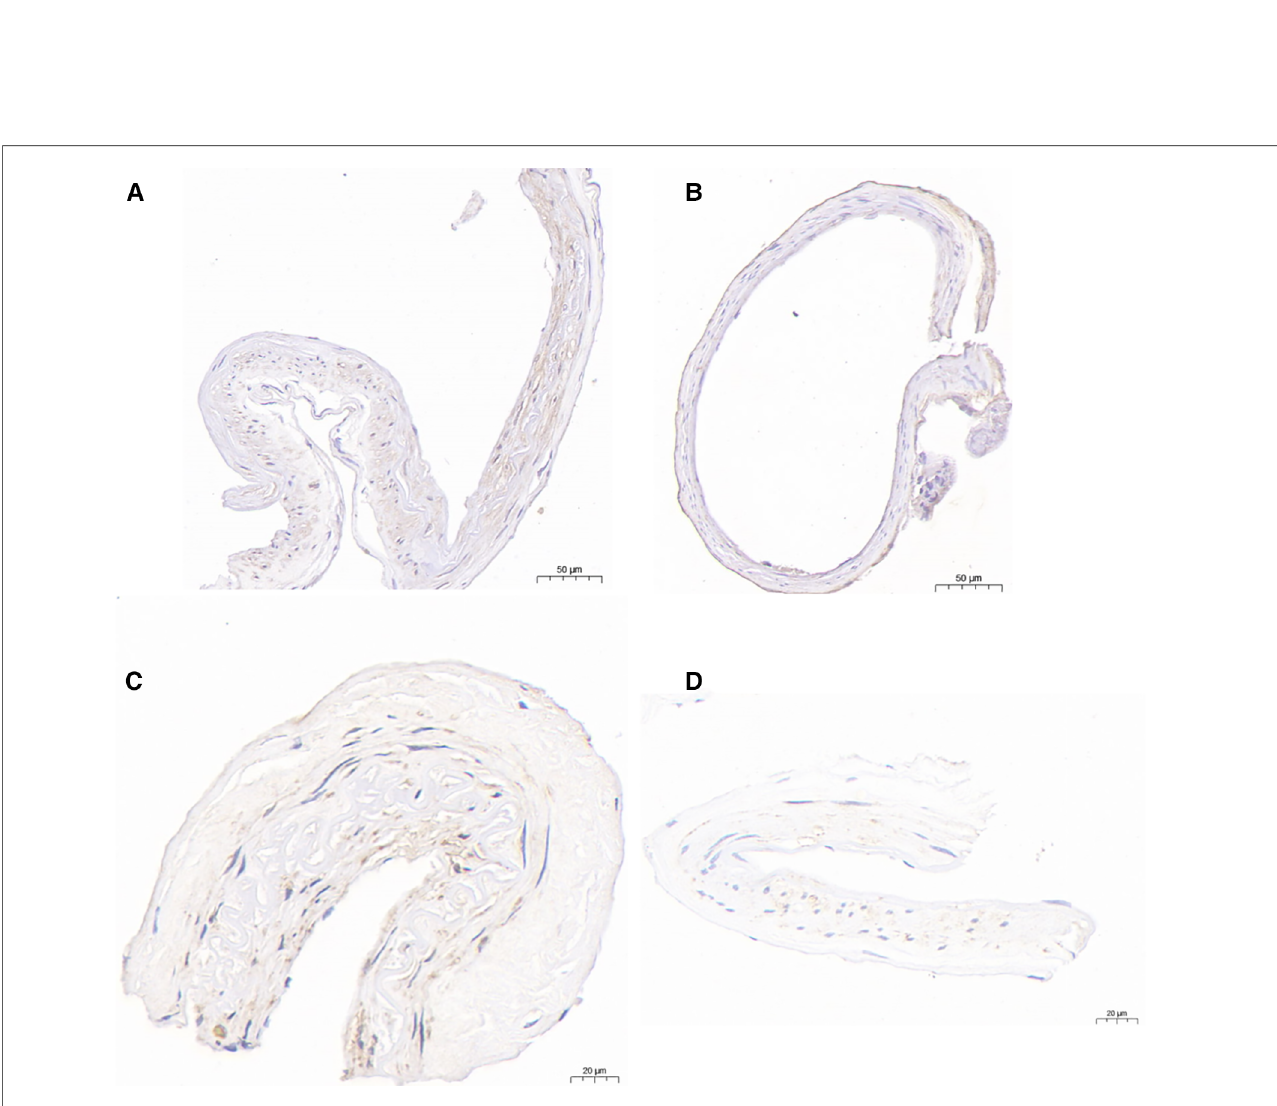
FIGURE 4 Immunohistochemical analysis of HIF-1 α and MMP-9.HIF-1 α -immunopositive cells were detected in the PSCAs specimens from patients with non-M-PSCAs MMD ( A ). ( B ), in M-PSCAs MMD, a smaller number of such cells are detected. MMP-9-immunopositive cells were detected in the PSCAs specimens from patients with non-M-PSCAs MMD ( C ). ( D ), in M-PSCAs MMD, a smaller number of such cells are detected. Scale bar, 50 µ m ( A,B ) and 20 µ m ( C,D ); original magni fi cation, ×20 ( A,B ) and ×40 ( C,D